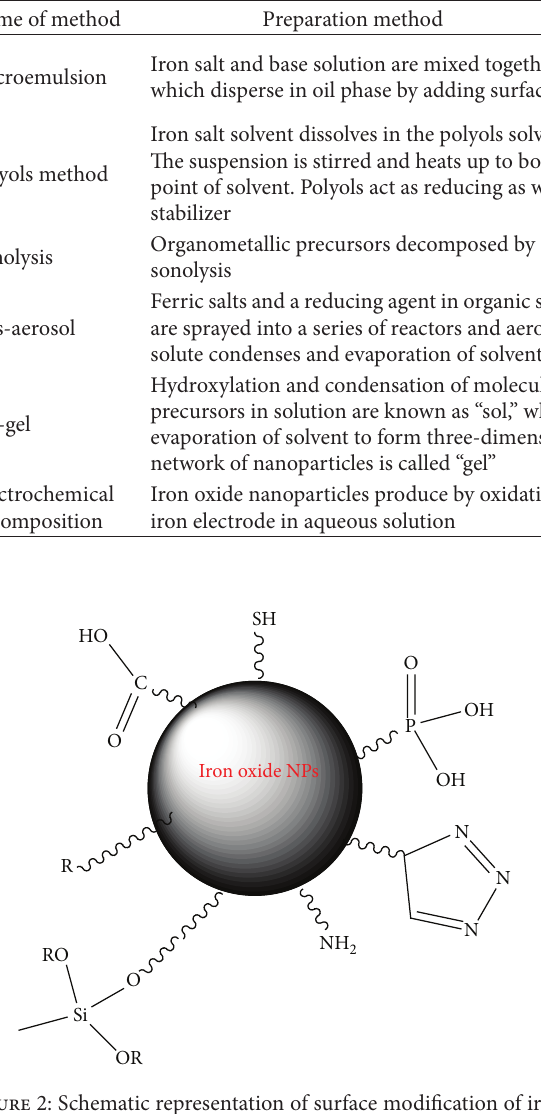
Table 1: Various chemical methods for synthesis of iron oxide nanoparticles.